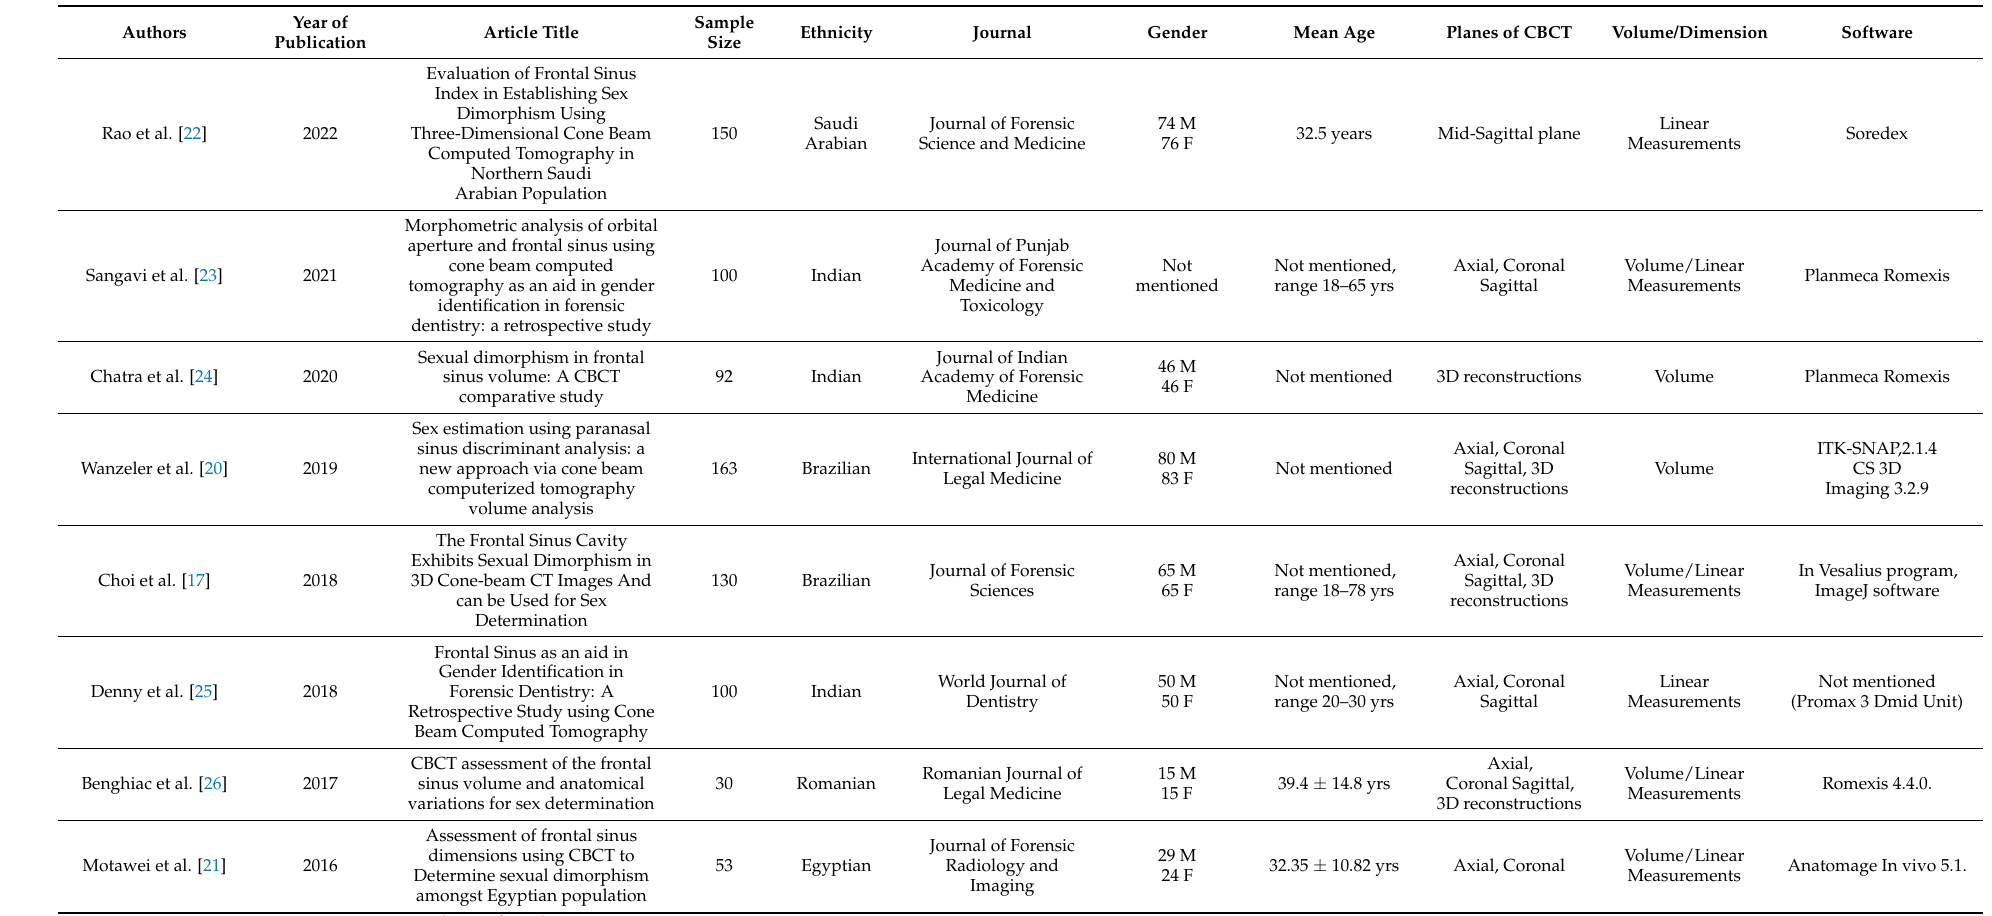
Table 1. Data extraction from the included in the review